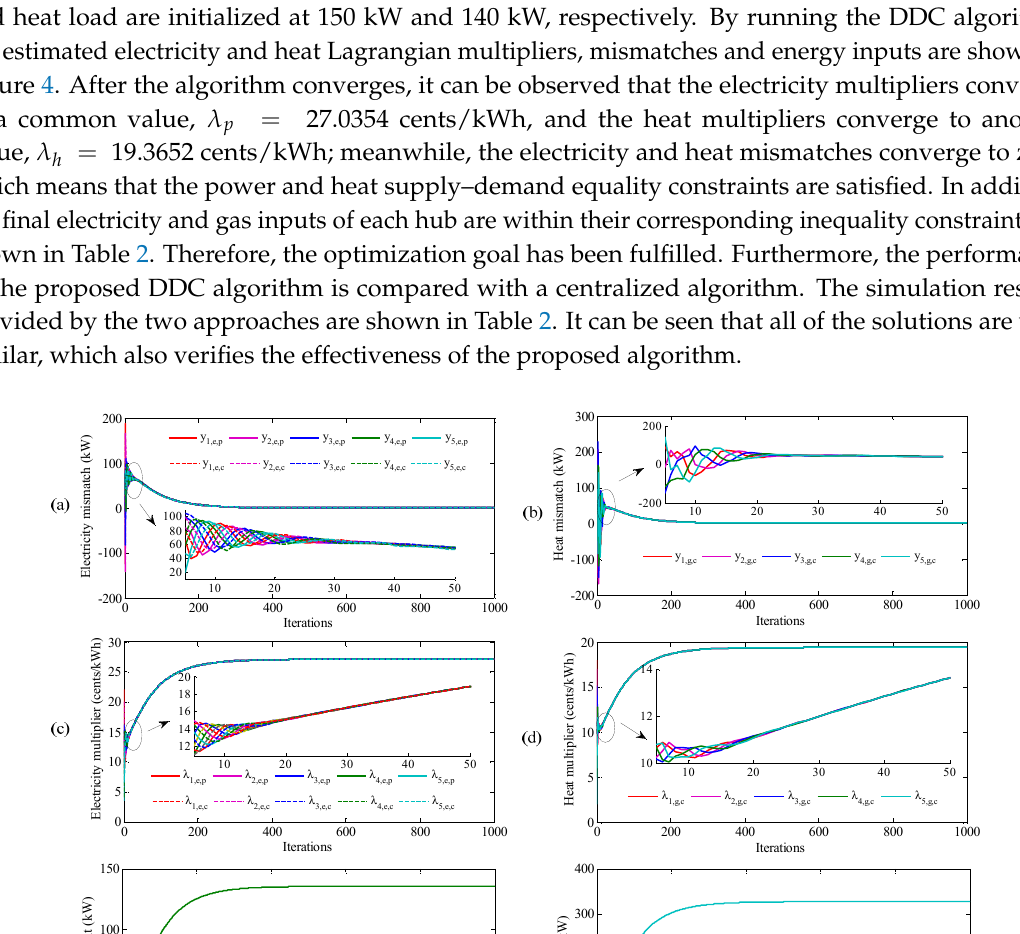
Table 2. Comparison with centralized algorithm.